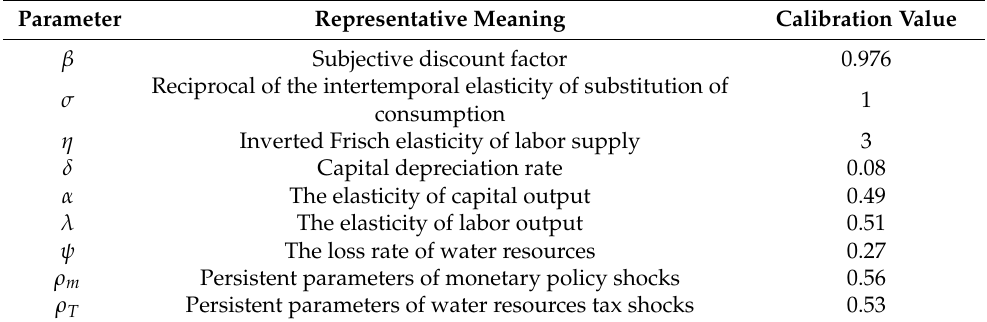
Table 2. Summary of parameter setting